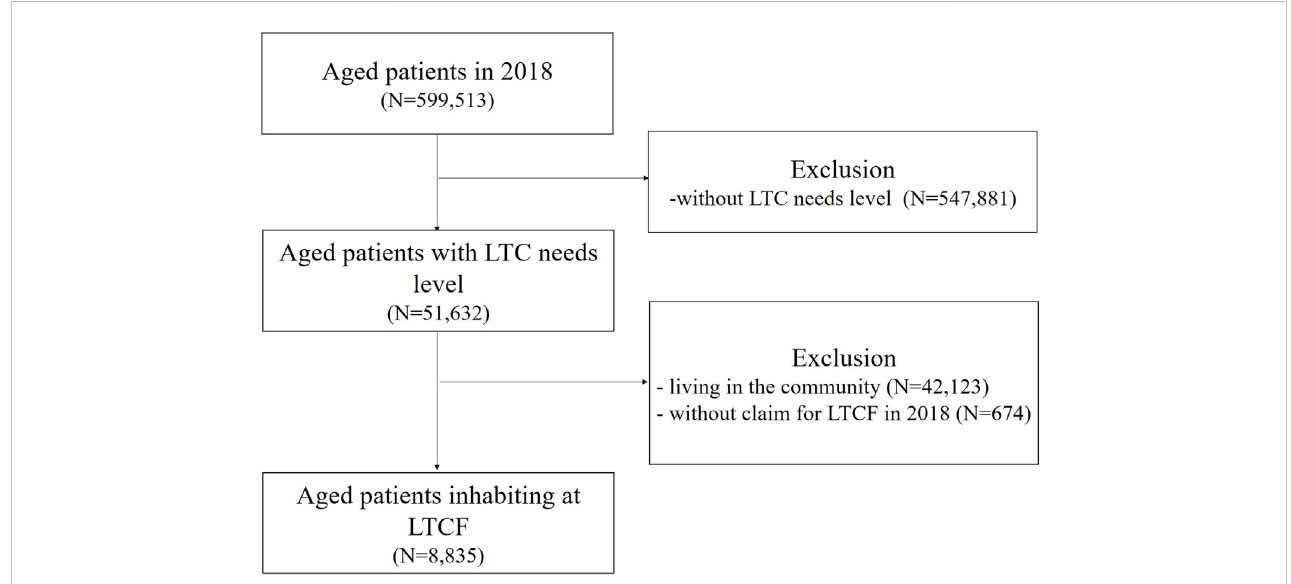
FIGURE 1 Flowchart for patient seletion. LTC, long-term care; LTCF, long-term care facility.